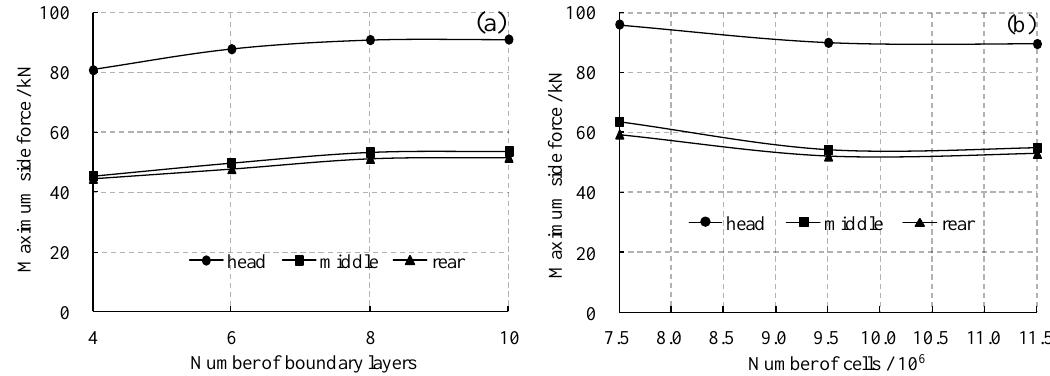
Figure 11. Maximum side force of three carriages under conditions of ( a ) di ff erent boundary layer densities and ( b ) mesh element numbers (train speed = 250 km / h; wind velocity = 25 m /